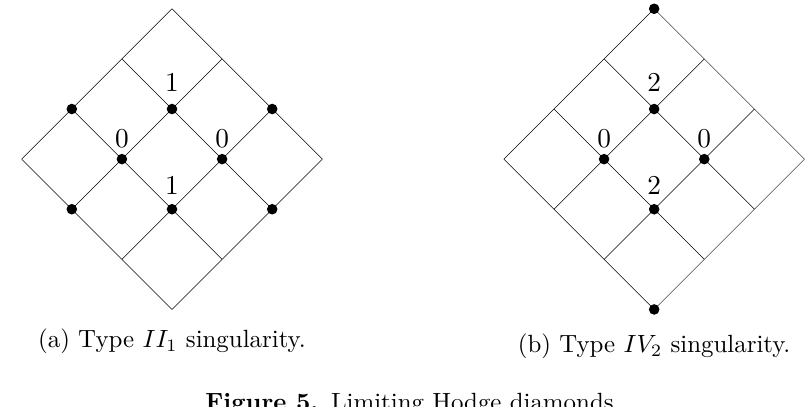
Figure 5. Limiting Hodge diamonds.